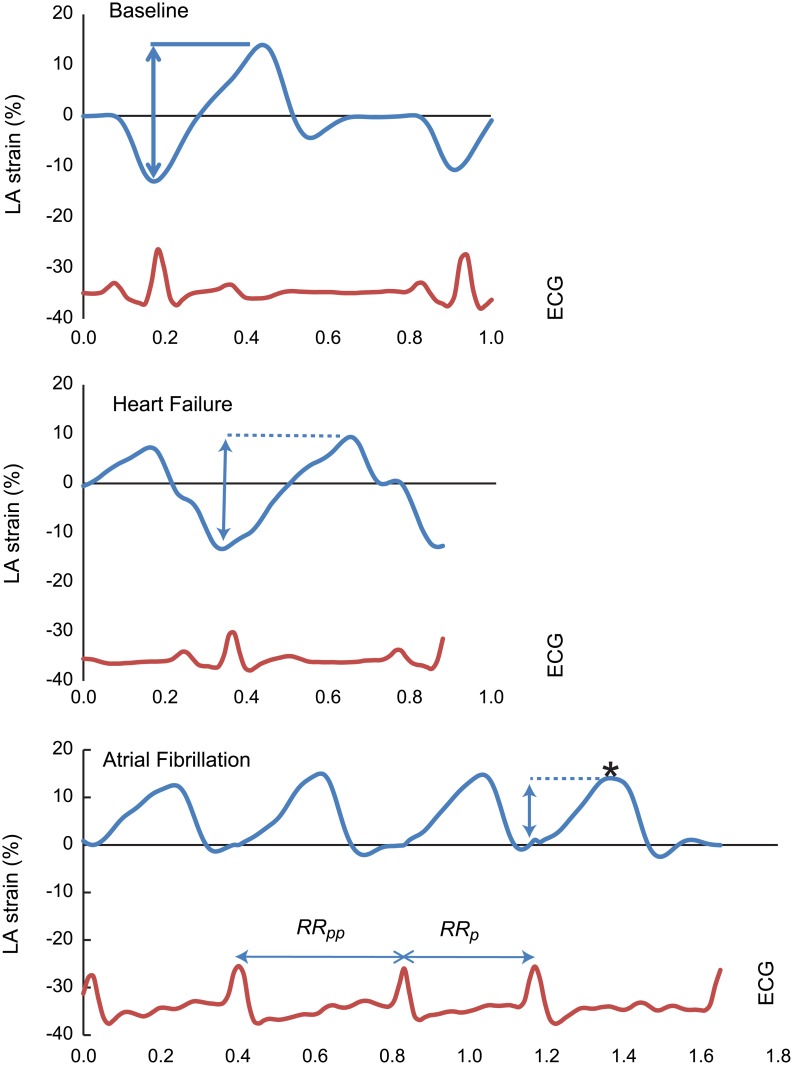
A representative example of left atrial (LA) strain obtained at baseline, after heart failure development with the animal in normal sinus rhythm, and after subsequent atrial fibrilation induction in a same single animal from vagal nerve stimulation (VNS) treated group.ECG: electrocardiogram. RRp and RRpp: RR intervals that precede and pre-precede index left atrial strain (marked by an asterisk). Time (x) axis is in seconds